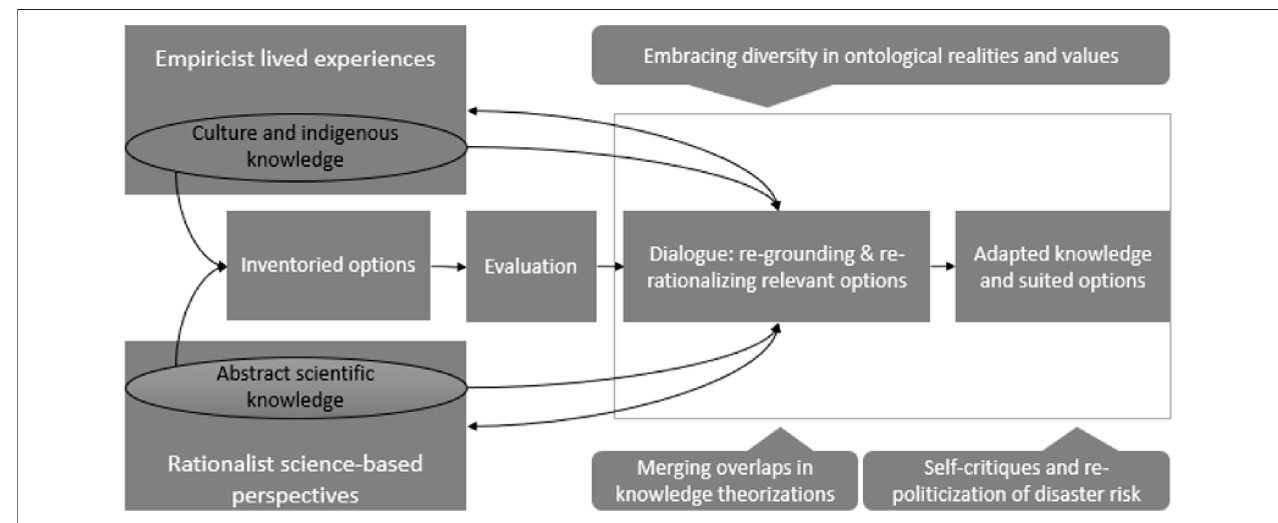
FIGURE 3 | Observed process from inventorying to co-creation of knowledge and co-development of suitable DRR options.